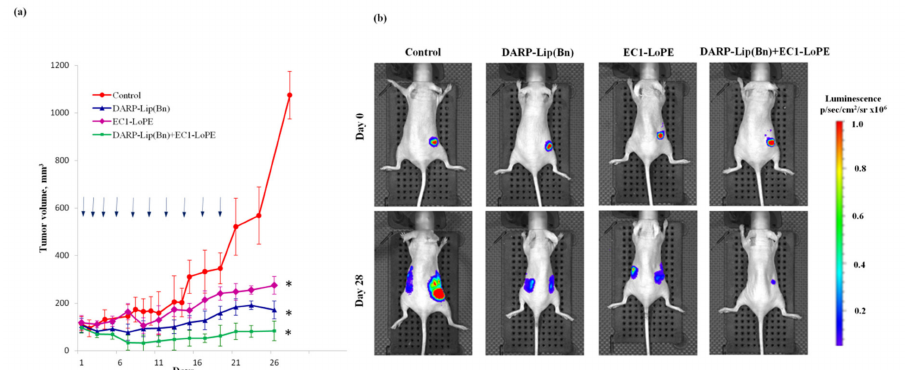
Figure 5. In vivo therapy and IVIS imaging: ( a ) Tumor growth dynamics upon the treatment with PBS, DARP-Lip(Bn), EC1-LoPE or DARP-Lip(Bn) plus EC1-LoPE. Arrows indicate the time of injection; bars indicate